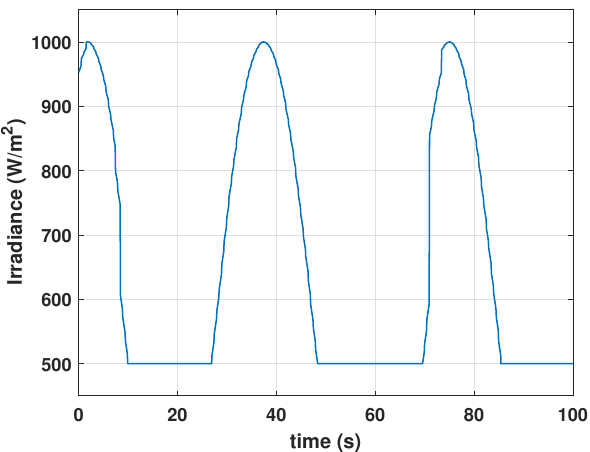
Figure 12. Solar irradiation variation.